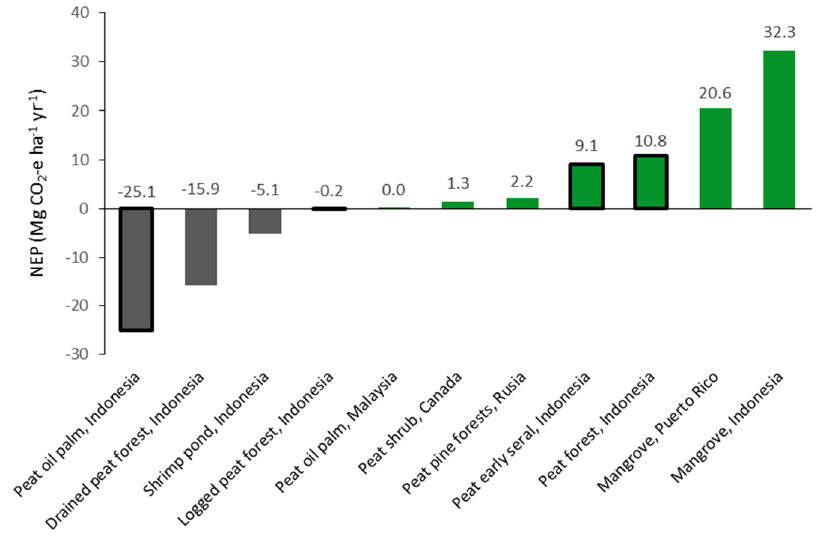
Figure 6. Net ecosystem production among wetland ecosystems. Data for mangrove are from [51,53]. Shrimp pond is from [53]. Peat oil palm is from [56] and this study. Peat pine forest and drained peat forests are from [54,58]. Peat shrub is from [59]. Peat forest, logged peat forest, oil palm, and early seral are from this study (bordered with black line).